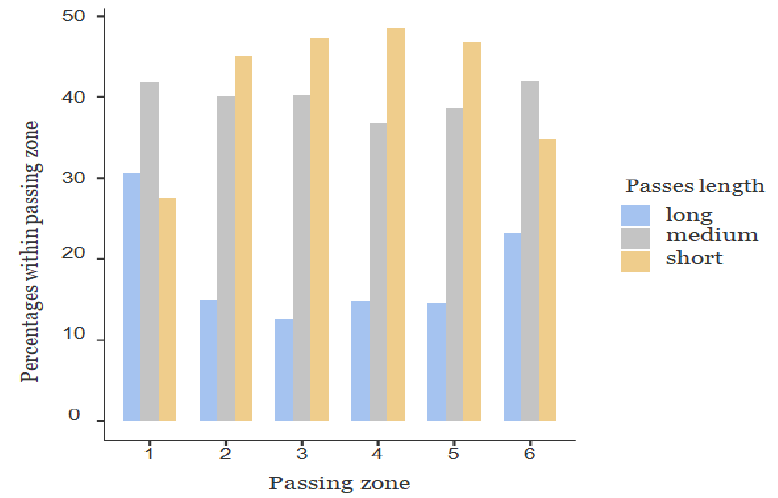
Figure 2. Distribution of the total number of passes by field zone.